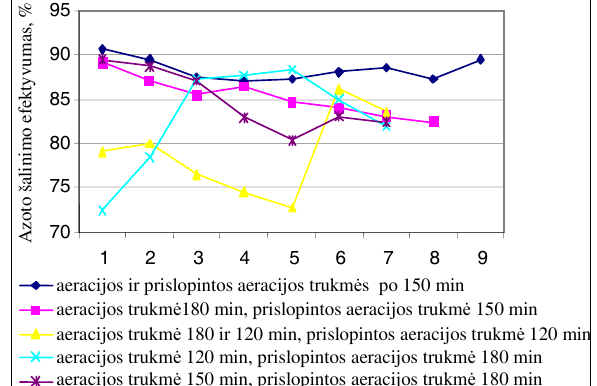
skirtingais aeravimo režimais Fig 16. Nitrogen removal efficiency at different aeration regime of aeration tanks 6. Išvados